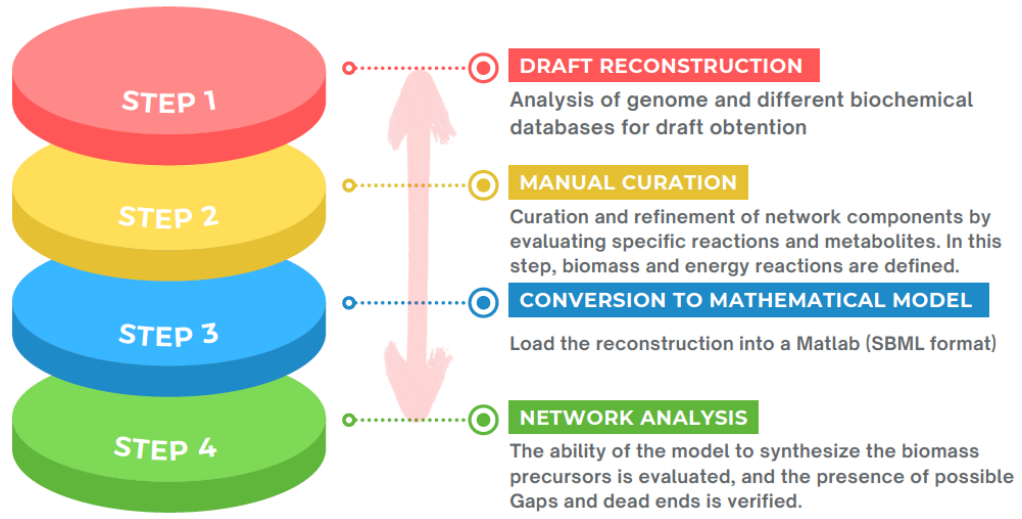
Figure 5. Schematic representation of the workflow for obtaining high-quality GEMs.